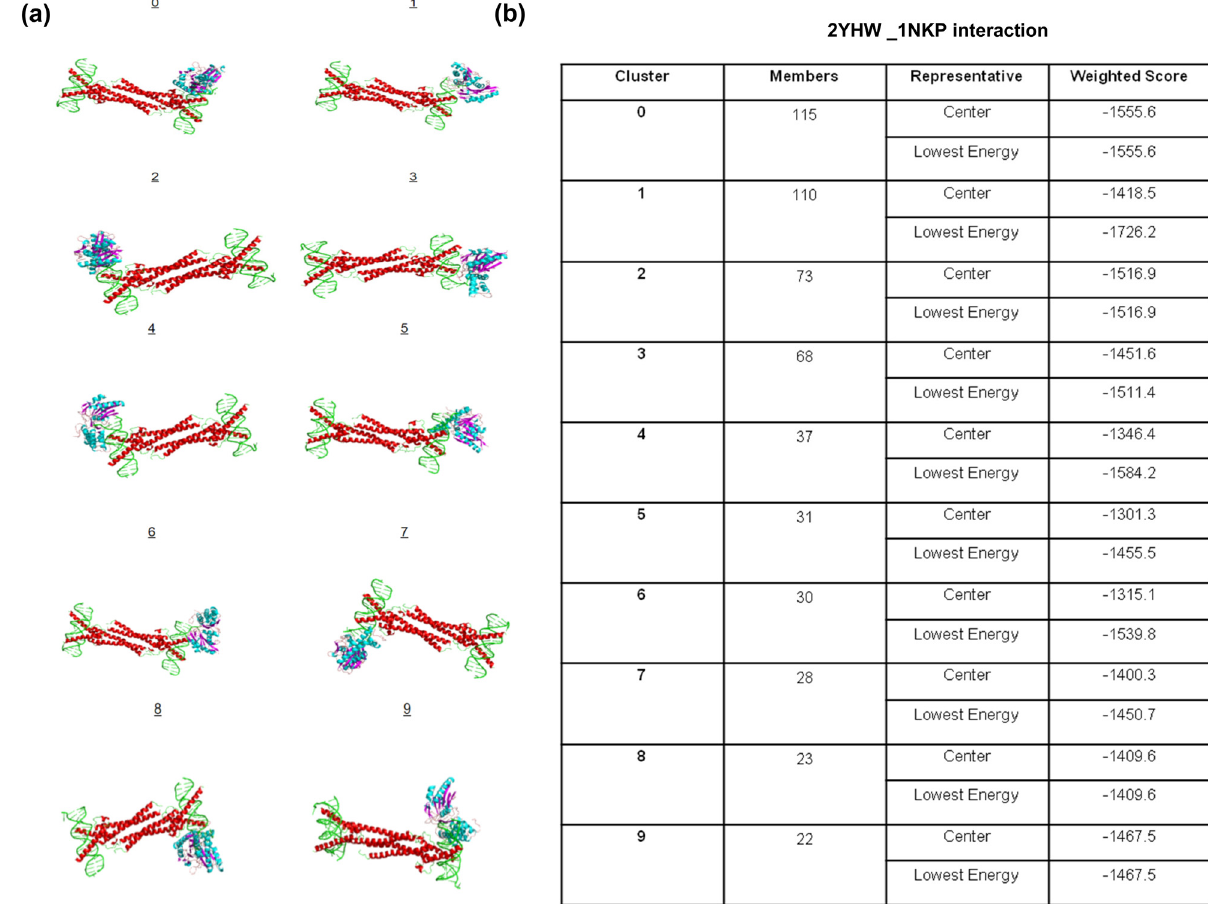
Figure 5: ClusPro - based analysis of molecular docking results: ( a ) top 10 predicted interactions of GNE protein domain ( 2YHW ) and the MYC domain ( PDB entery 1NKP ) and ( b ) cluster scores for each predicted